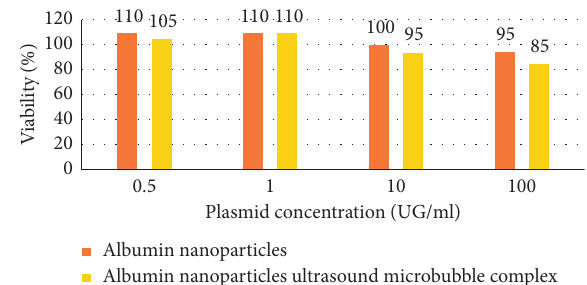
Figure 2: Cell viability of nanoparticles and nanoparticle ultrasound microbubble complexes.